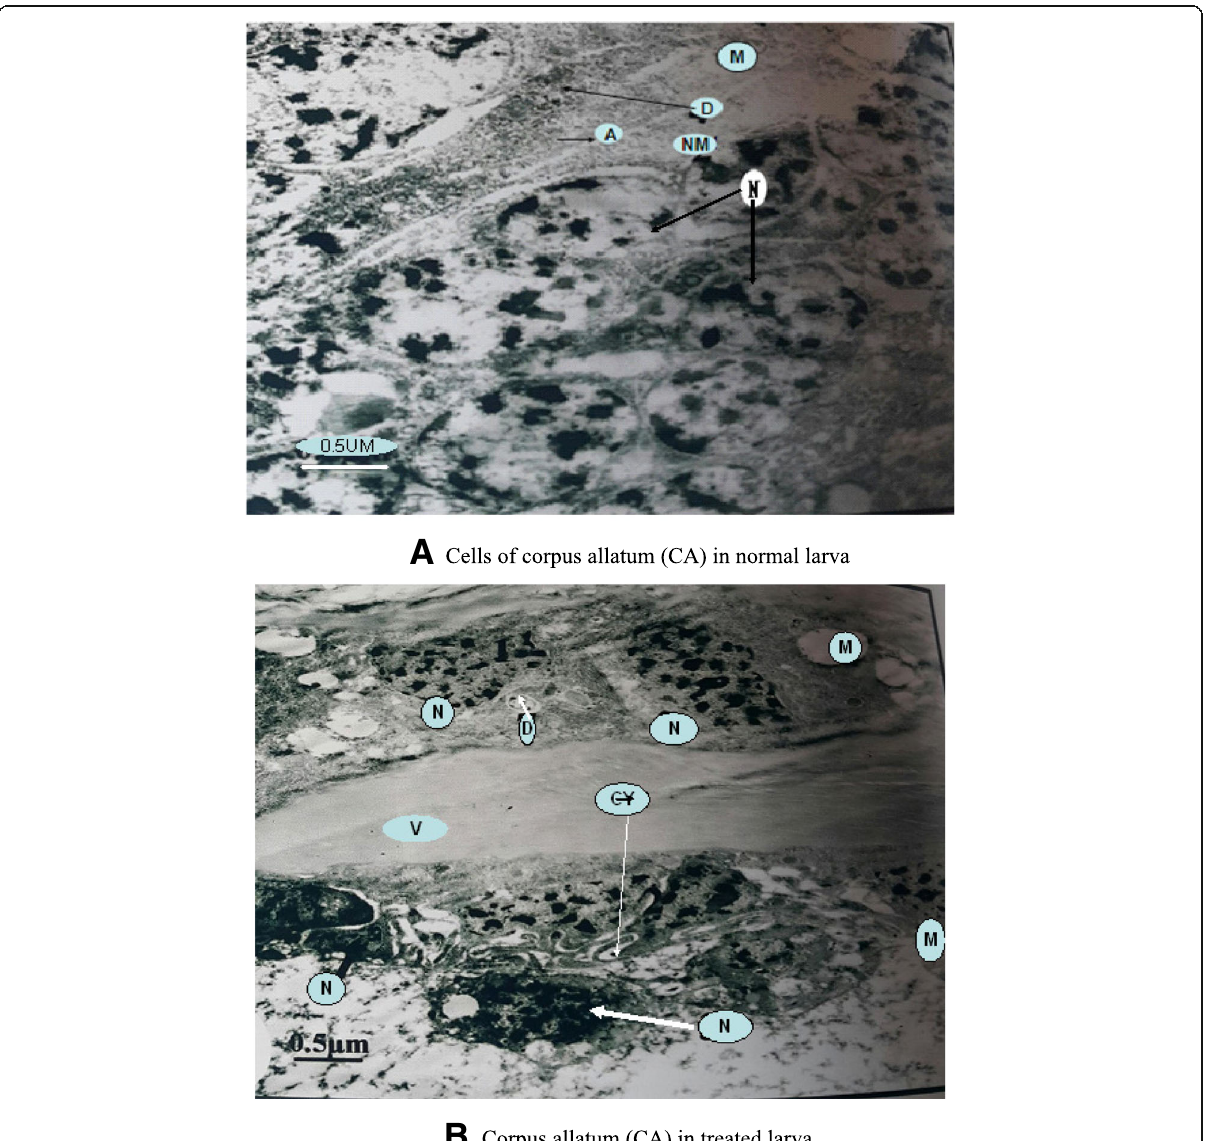
Fig. 8 a Cells of corpus allatum (CA) in normal larva. b Corpus allatum (CA) in treated larva. Sections in different tissues of the endocrine system of the potato tuber moth Phthorimaea operculalla larva detected under electron microscope observation . a The normal untreated tissues. b The treated tissues of larva reared on potato tubers covered with talcum powder containing 0.5% each of basil extract + B.t + GV and 25 g/1 kg